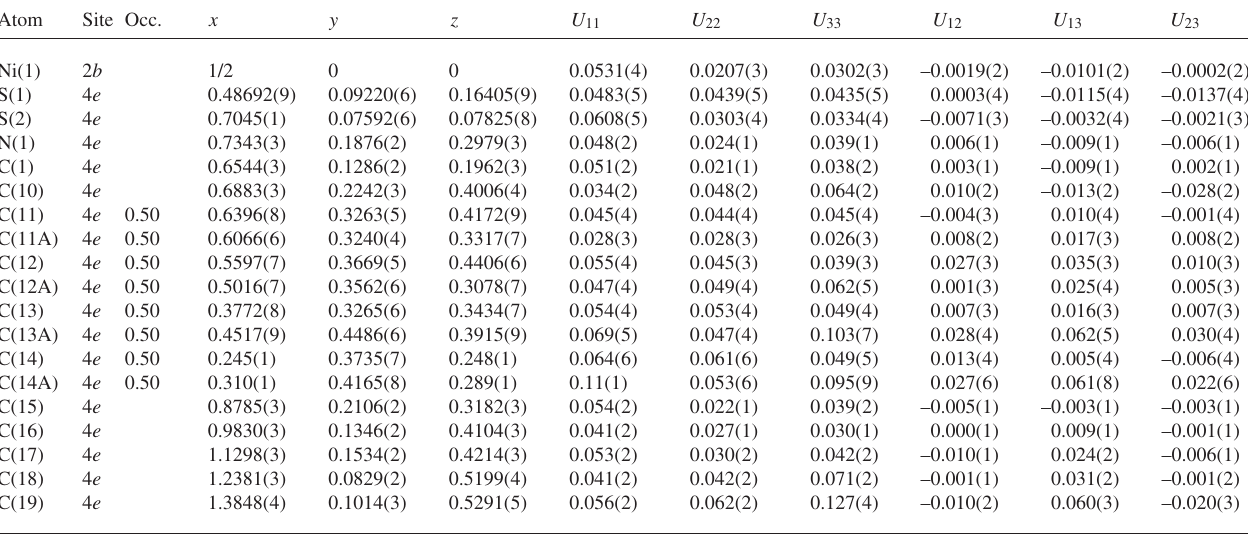
Table 3. Atomic coordinates and displacement parameters (in Å 2 )